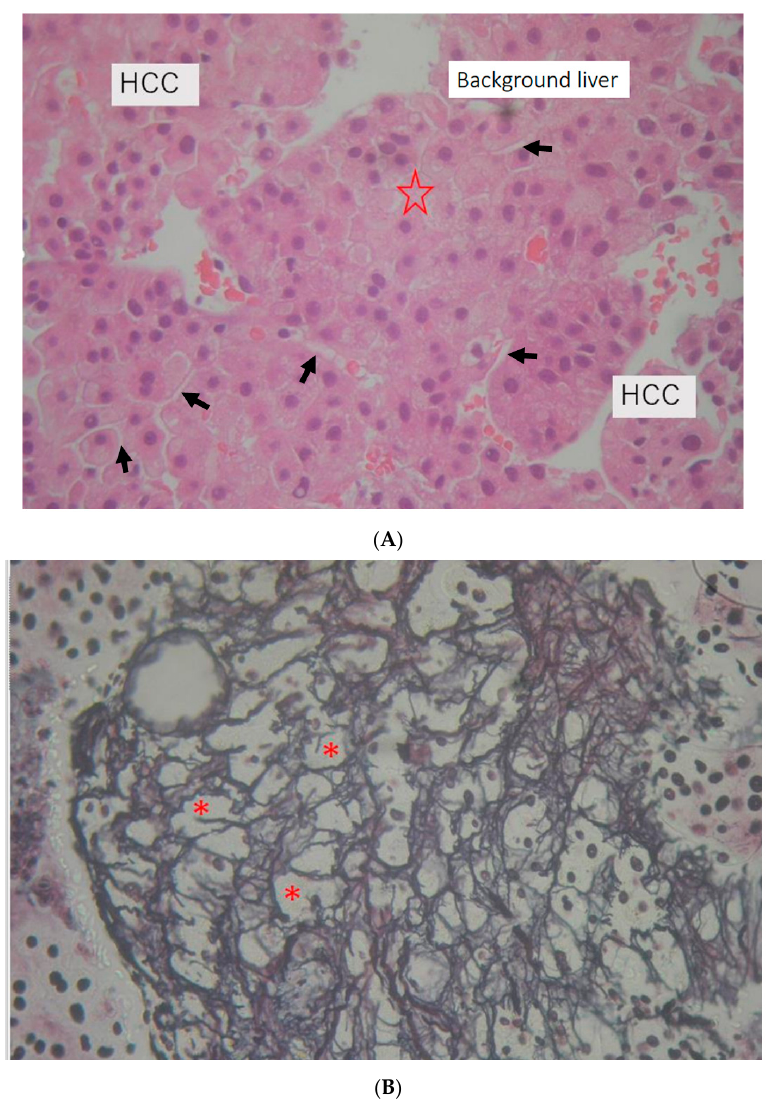
Figure 2. Pathology of liver biopsy (Case 1) at 1.5 months after stereotactic body radiotherapy (SBRT). ( A ) × 40 Hematoxylin and eosin staining; HCC and background liver HCC sniped biopsy include background liver tissue. Degenerated focus ( (cid:73) ). Endothelial cells (black arrows) are shown in the background liver. ( B ) × 40 silver impregnation stain; irregular reticulin frame work. Hepatocytes fell off (*) in the background liver tissue